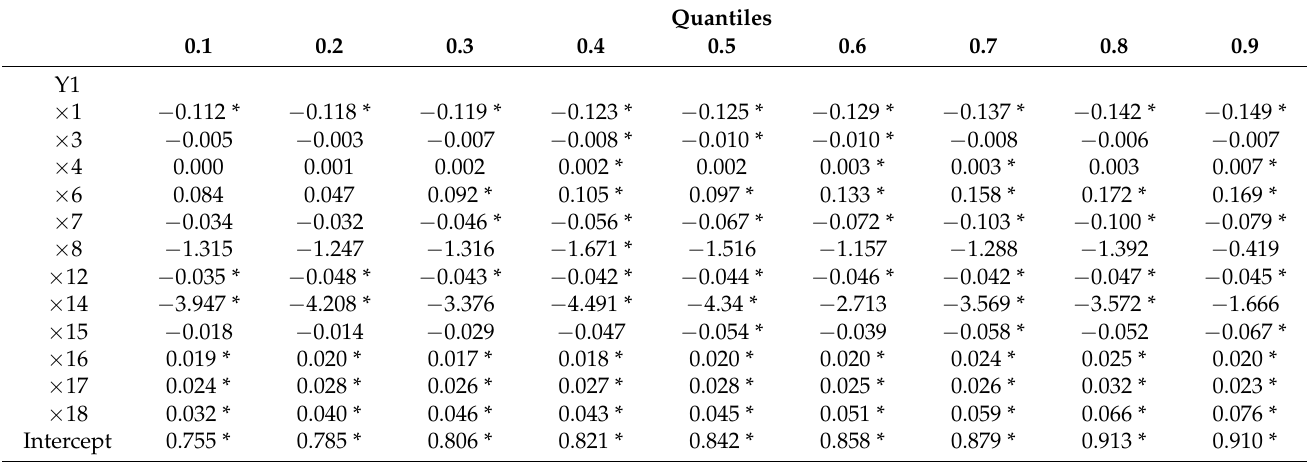
Table 2. Results of quantile regression